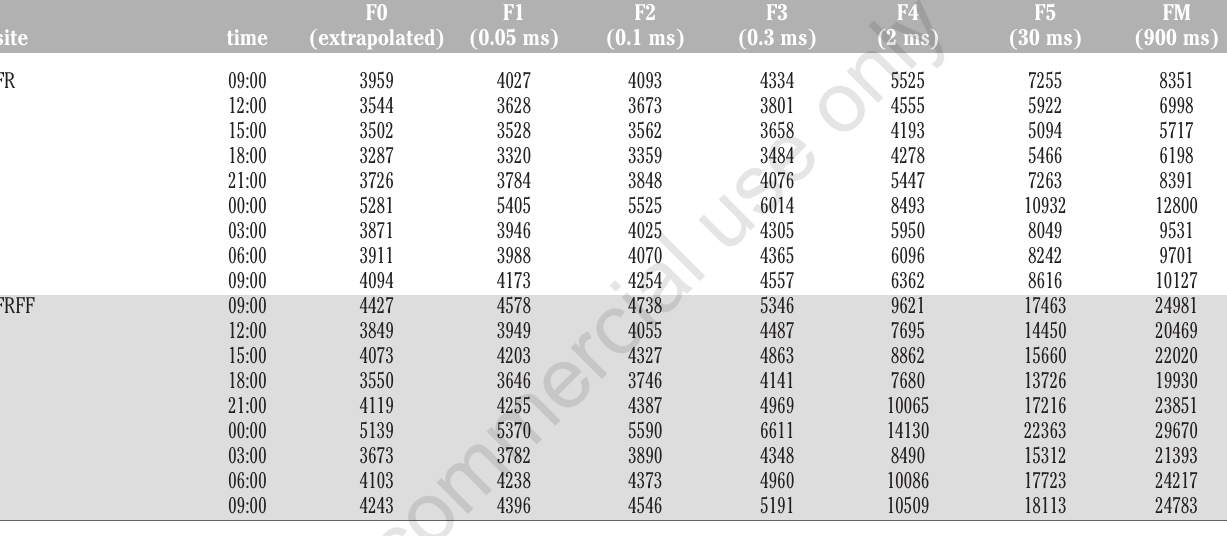
Table 2. Mean values of raw fluorescence intensities of the Pocket-PEA measurements at T0-T5 and for the maximum fluorescence (FM) for all data points in Figures 1-2 at the Frankfurt site outdoors (FR) and at the Frankfurt site under frost-free conditions (FRFF); Measuring Date: 14.01.2010.